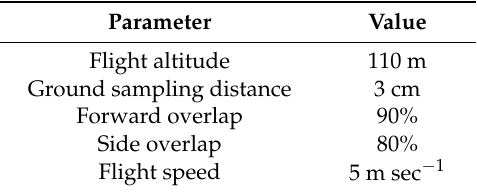
Table 2. Summary of the image acquisition